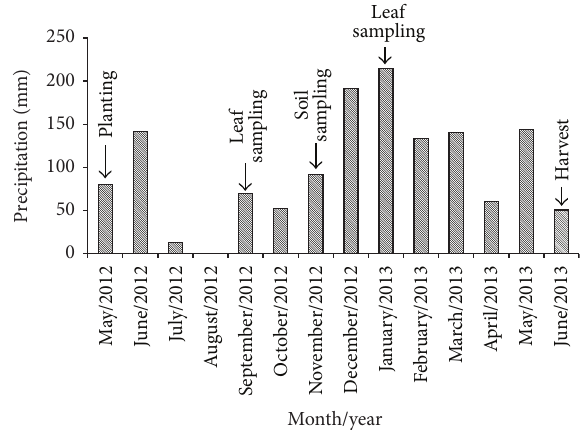
Figure 1: Monthly accumulated precipitation during the experi- ment. Source: